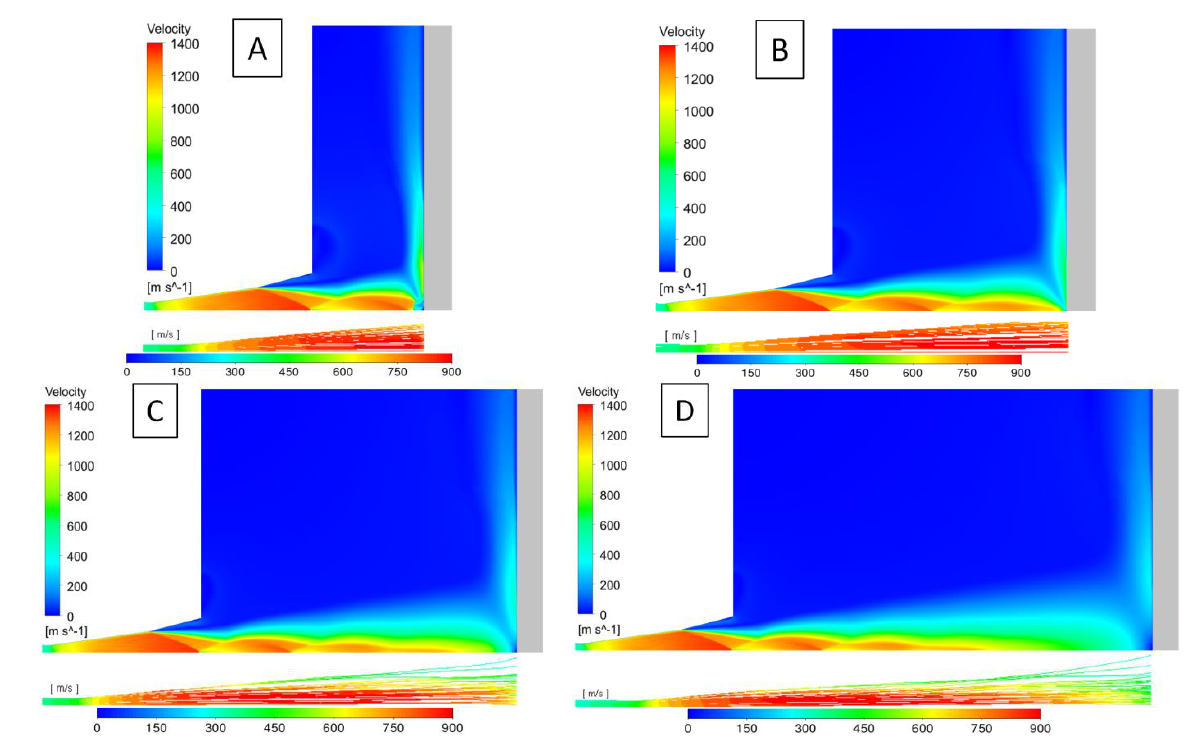
Figure 14. The velocity profiles of the gas stream (left side) and deposited particles (right side) as a function of standoff distance: ( A )—20 mm, ( B )—40 mm, ( C )—60 mm, ( D )—80 mm.